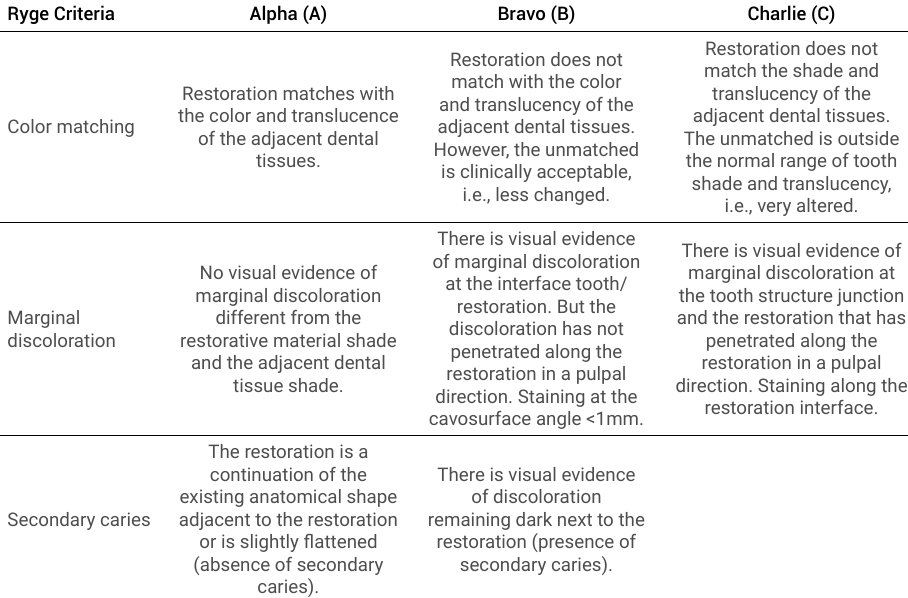
Table 1. Ryge’s criteria - Modified United States Public Health Service (USPHS). Ryge